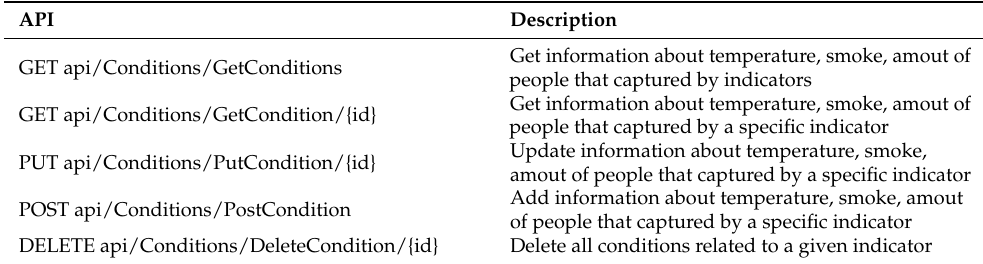
Table 2. Description of Conditions